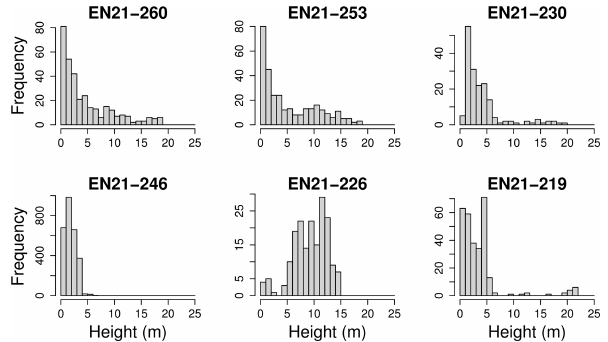
Figure 5. The height classes among all species for six different plots of the Yakutia 2021 expedition, which were chosen as exam- ples for differing height distributions.